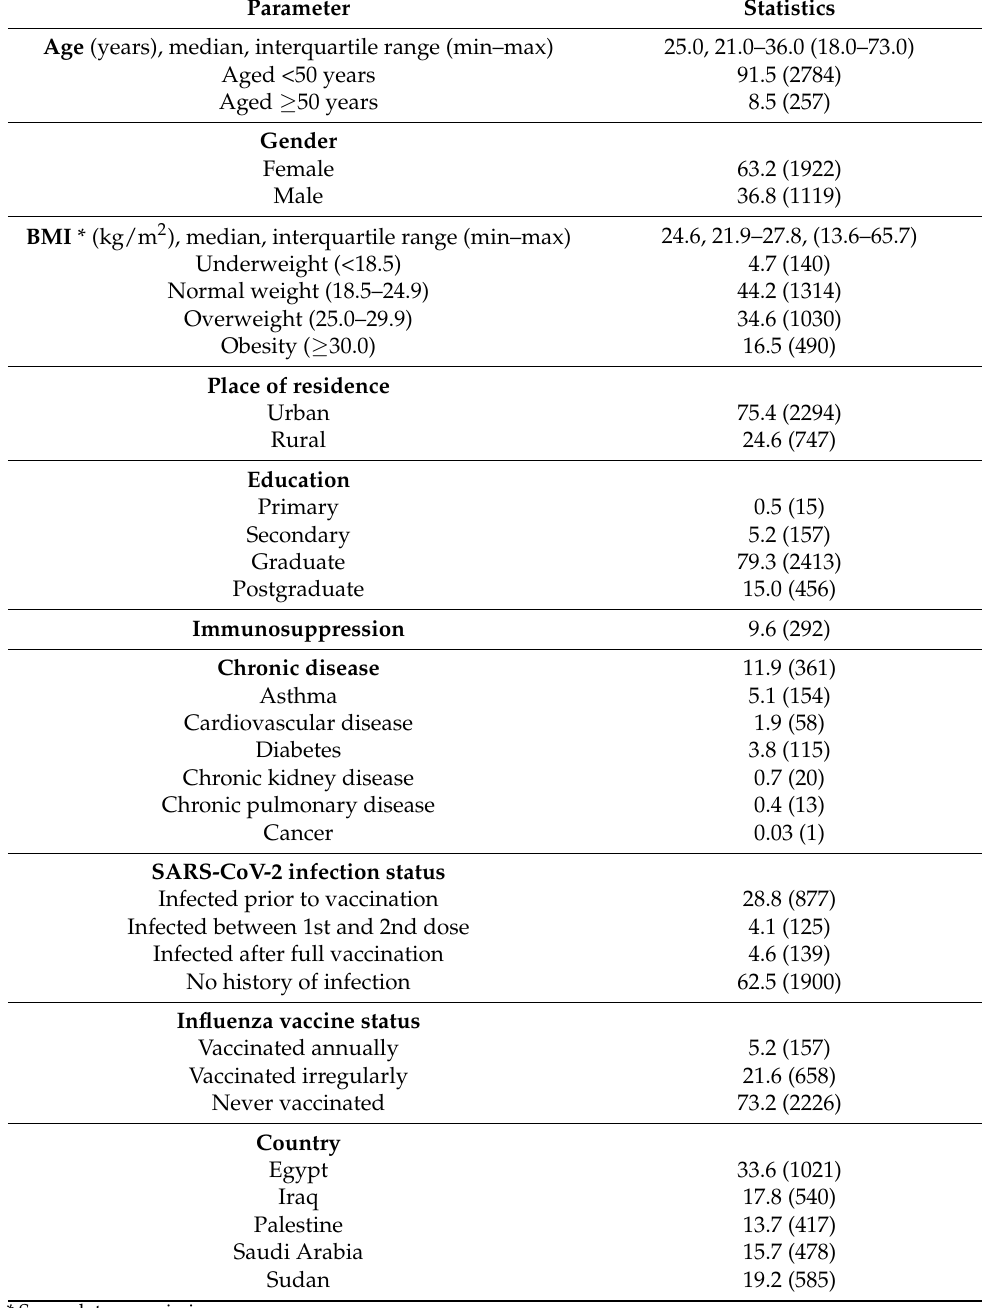
Table 1. Demographic characteristics of the respondents ( n = 3041), data reported as % ( n